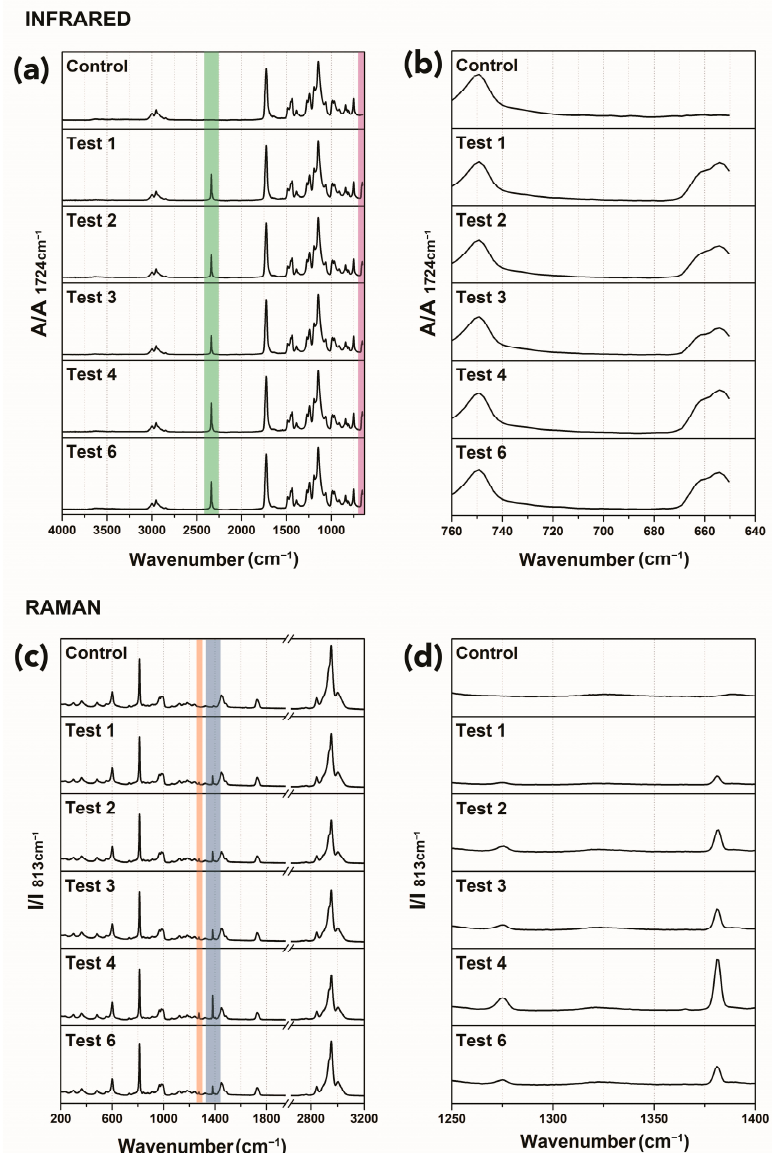
Figure 7. ( a ) ATR-FTIR spectra overlaid, ( b ) detail of the spectra in the region 760–640 cm − 1 , ( c ) Raman extended spectra, and ( d ) detail of the Raman spectra in the region 1250–1400 cm − 1 , for control (untreated PMMA sample) and samples subjected to CO 2 at different conditions. The colored rectangles in the spectra highlight the CO 2 absorption bands at approximately 2338 cm − 1 (highlighted in green, panel a) and at 662 and 654 cm − 1 (highlighted in violet, panel a), while the orange and blue rectangles in the Raman spectra (panel c) highlight the peaks at 1391 and 1286 cm − 1 , respectively. All peaks are attributed to the CO 2 in the gas phase and dissolved in PMMA.